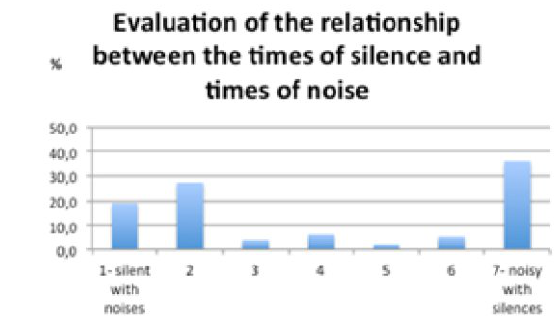
Fig. 13. Evaluation of the ratio between time periods of silence and noise.